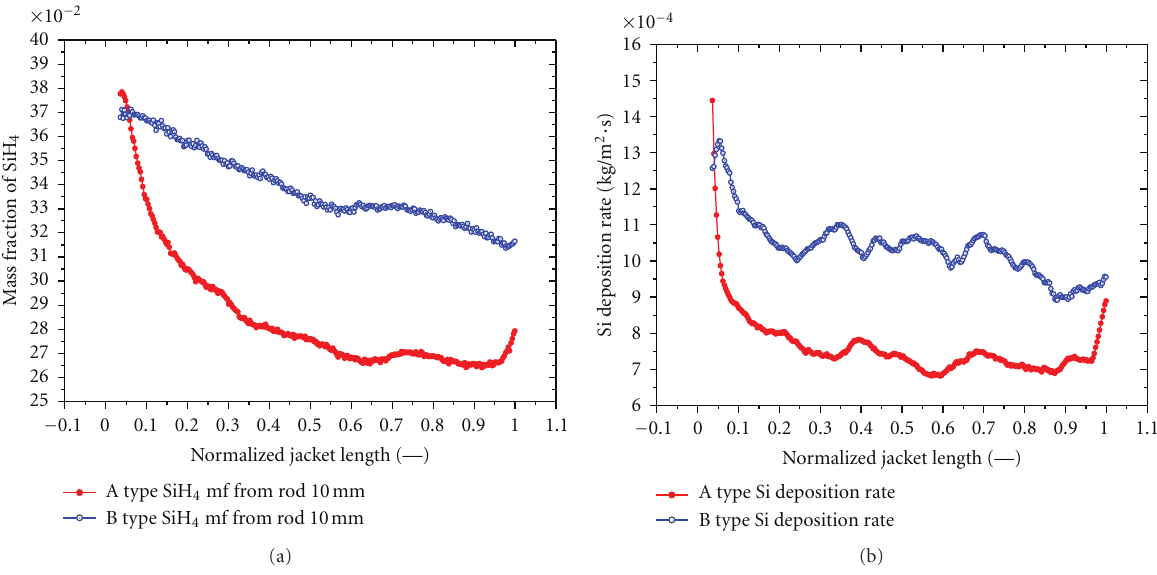
Figure 3: Simulation analysis of (a) SiH 4 mass fraction and (b) silicon deposition rate between type A and B nozzle.